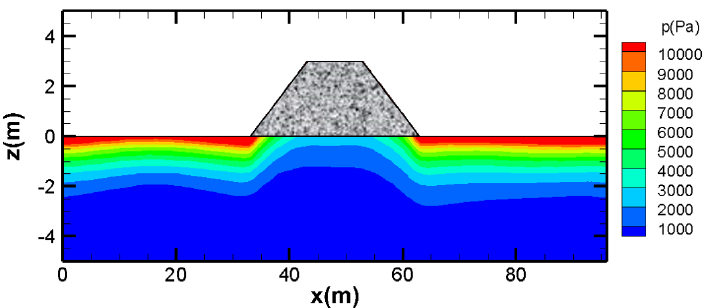
Figure 8. Distribution of the maximum pore pressure in the computational domain for T = 10